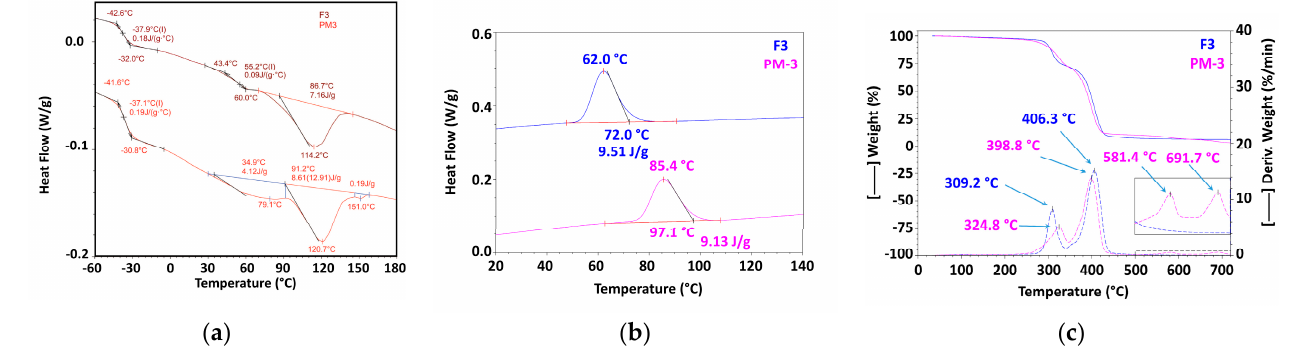
Figure 6. The thermal behavior of mechanically recycled (PM3) and primary compounds (F3) (( a ) melting from second heating; ( b ) crystallization; ( c ) TGA). Table 4. Glass transition of studied primary compounds.